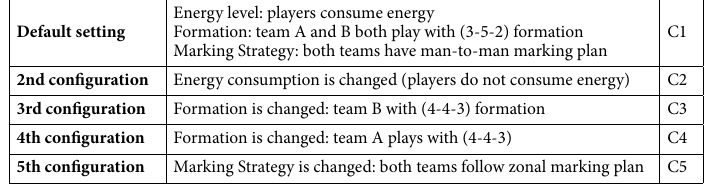
Table 4. A short list of the adjustable model